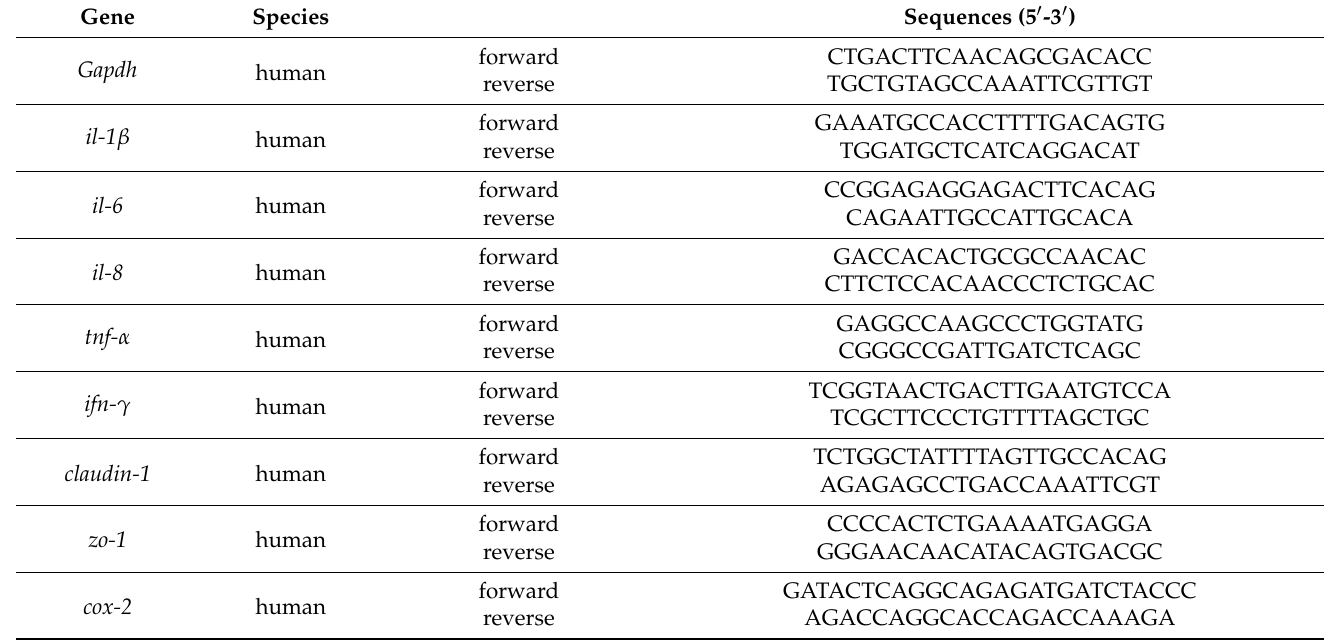
Table 1. Primers used for quantitative real-time